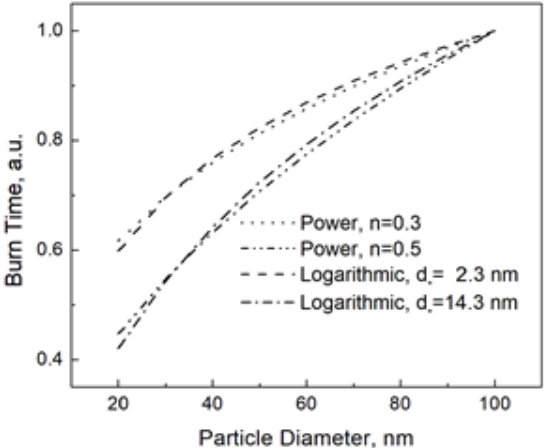
Figure 2. Power and logarithmic burn time laws at different parameters. The burn times at the given parameters are normalized to that for the nanoparticle size of 100 nm.